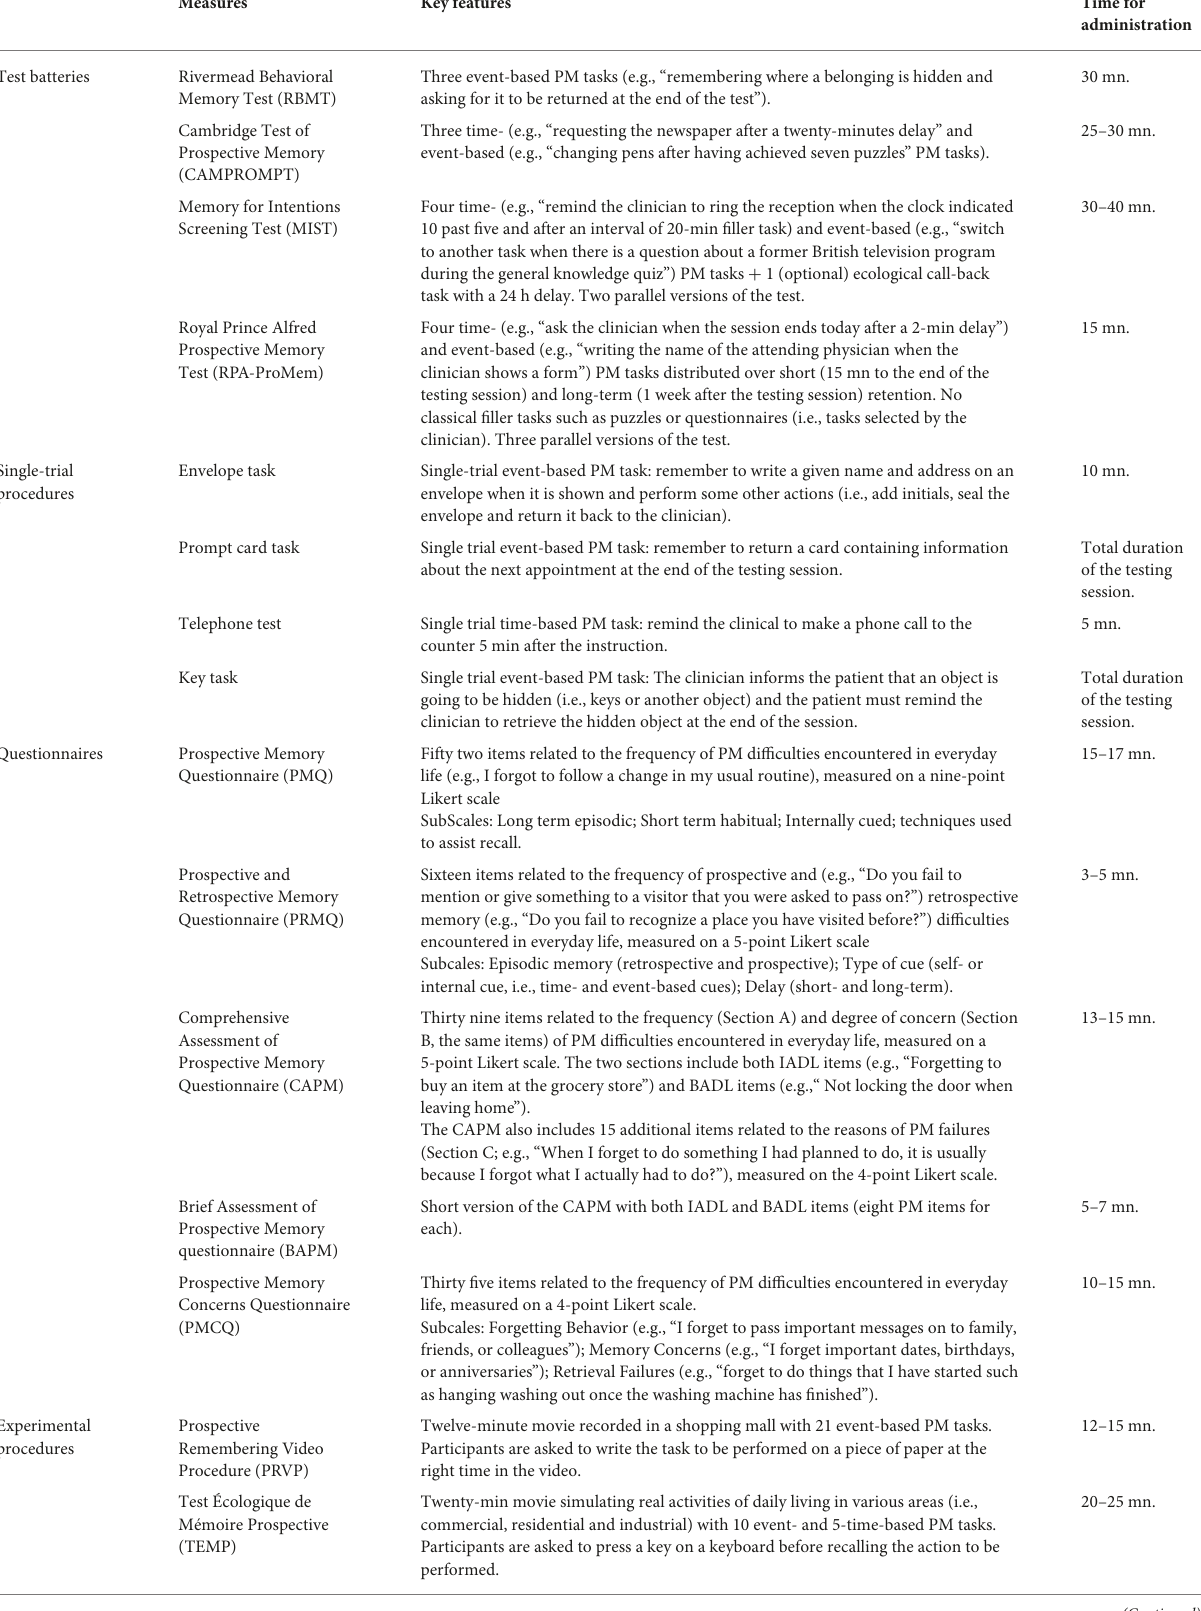
TABLE 1 Overview and brief description of the existing prospective memory (PM)